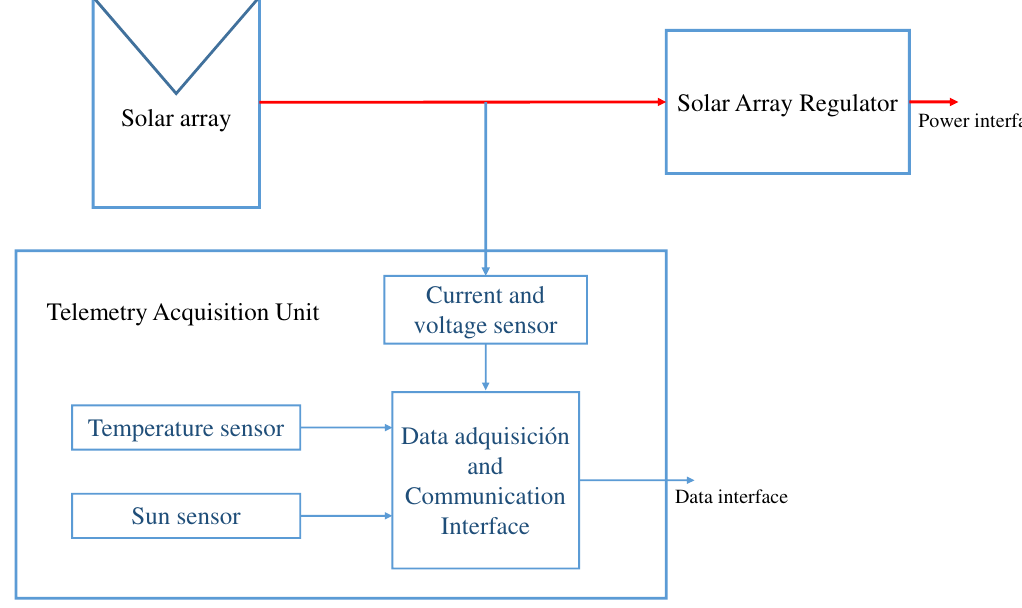
Figure 3. Architecture of Solar Module Integrated Converter